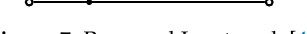
Figure 7. Reversed L network